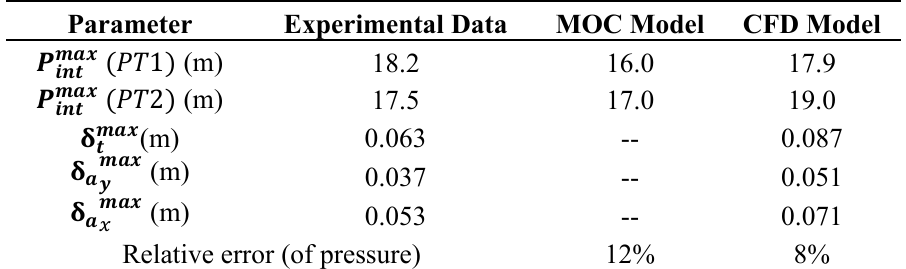
Table 4. Comparison between experimental data and computational